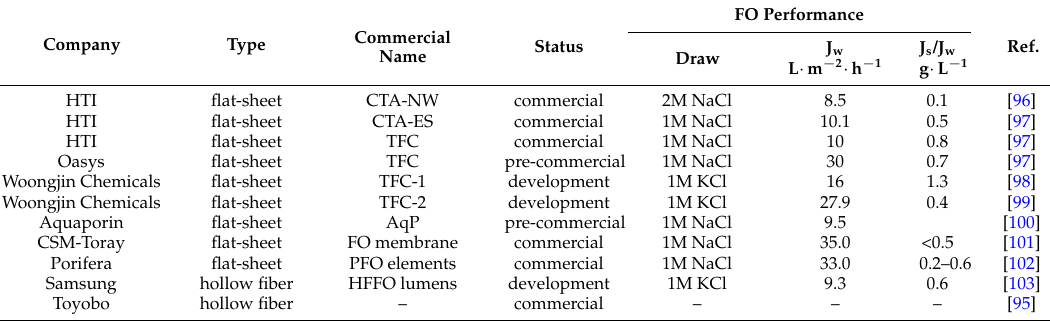
Table 1. Development and performance of commercial FO membranes (performance as seen in the literature with deionised water (DI) as feed and active layer facing feed solution (AL-FS) used as membrane orientation (data compiled in July